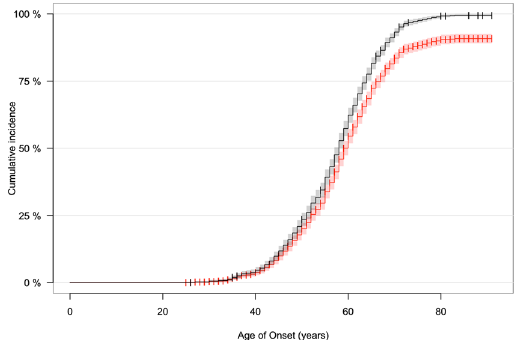
Figure 2. Age-related penetrance of the pathogenic C9orf72 repeat expansion. The black curve shows age- related penetrance of 1,147 symptomatic patients and 23 asymptomatic individuals carrying the C9orf72 repeat expansion. The shading represents the 95% confidence interval and censored individuals (i.e. asymptomatic) are indicated by crosses. The red curve represents model data in which the proportion of asymptomatic individuals is artificially increased to 20% (n =